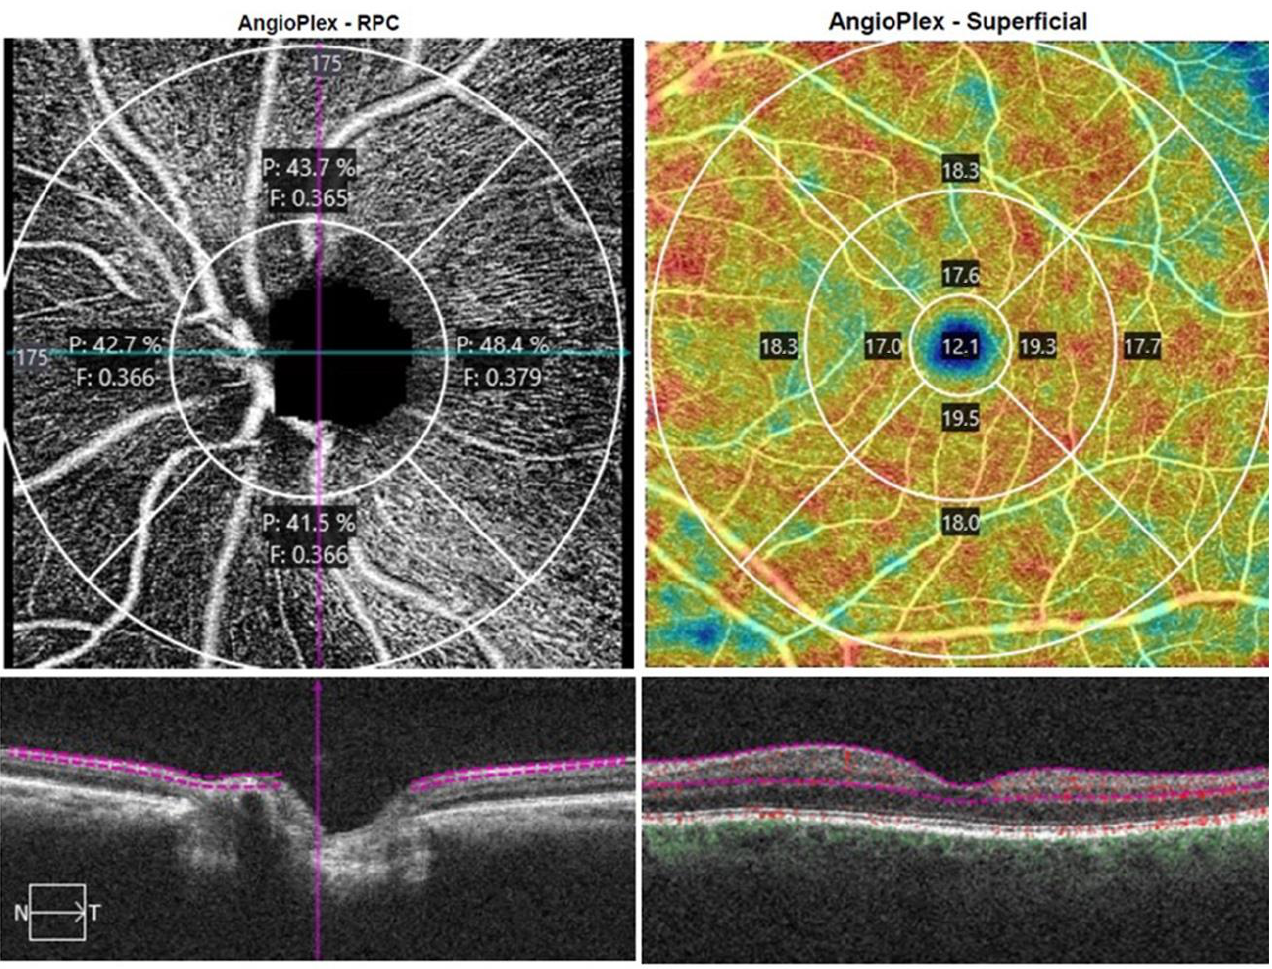
Figure 1. Peripapillary and macular vessel measurements offered by Angioplex OCTA in a glaucoma patient. Angiography slabs of the optic nerve head from a 4.5 × 4.5 mm scan showing the radial peripapillary capillary ( left ). Superficial angiography slabs of the 6 × 6 mm macular scan obtained using the OCT Cirrus 5000 ( right ).